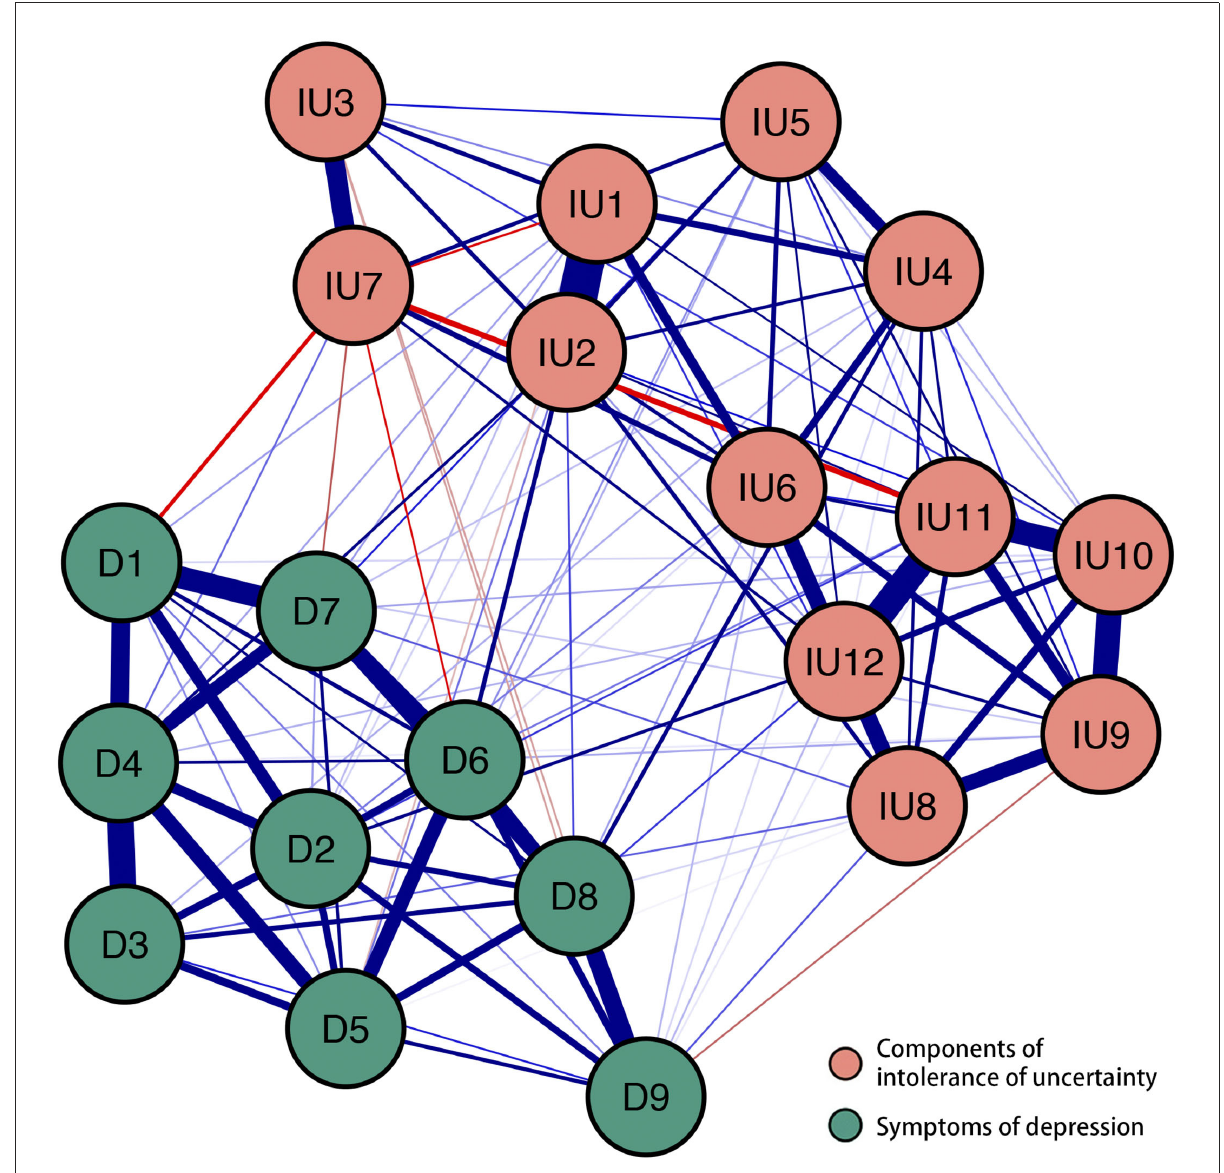
FIGURE1 The network structure of different components of intolerance of uncertainty and symptoms of depression. Positive correlations were shown by blue borders, whereas negative correlations were represented by red edges. The size of the correlation was reflected in the thickness of the edge. Cut value = 0.05. The text of intolerance of uncertainty and depression can be seen in Table 1.